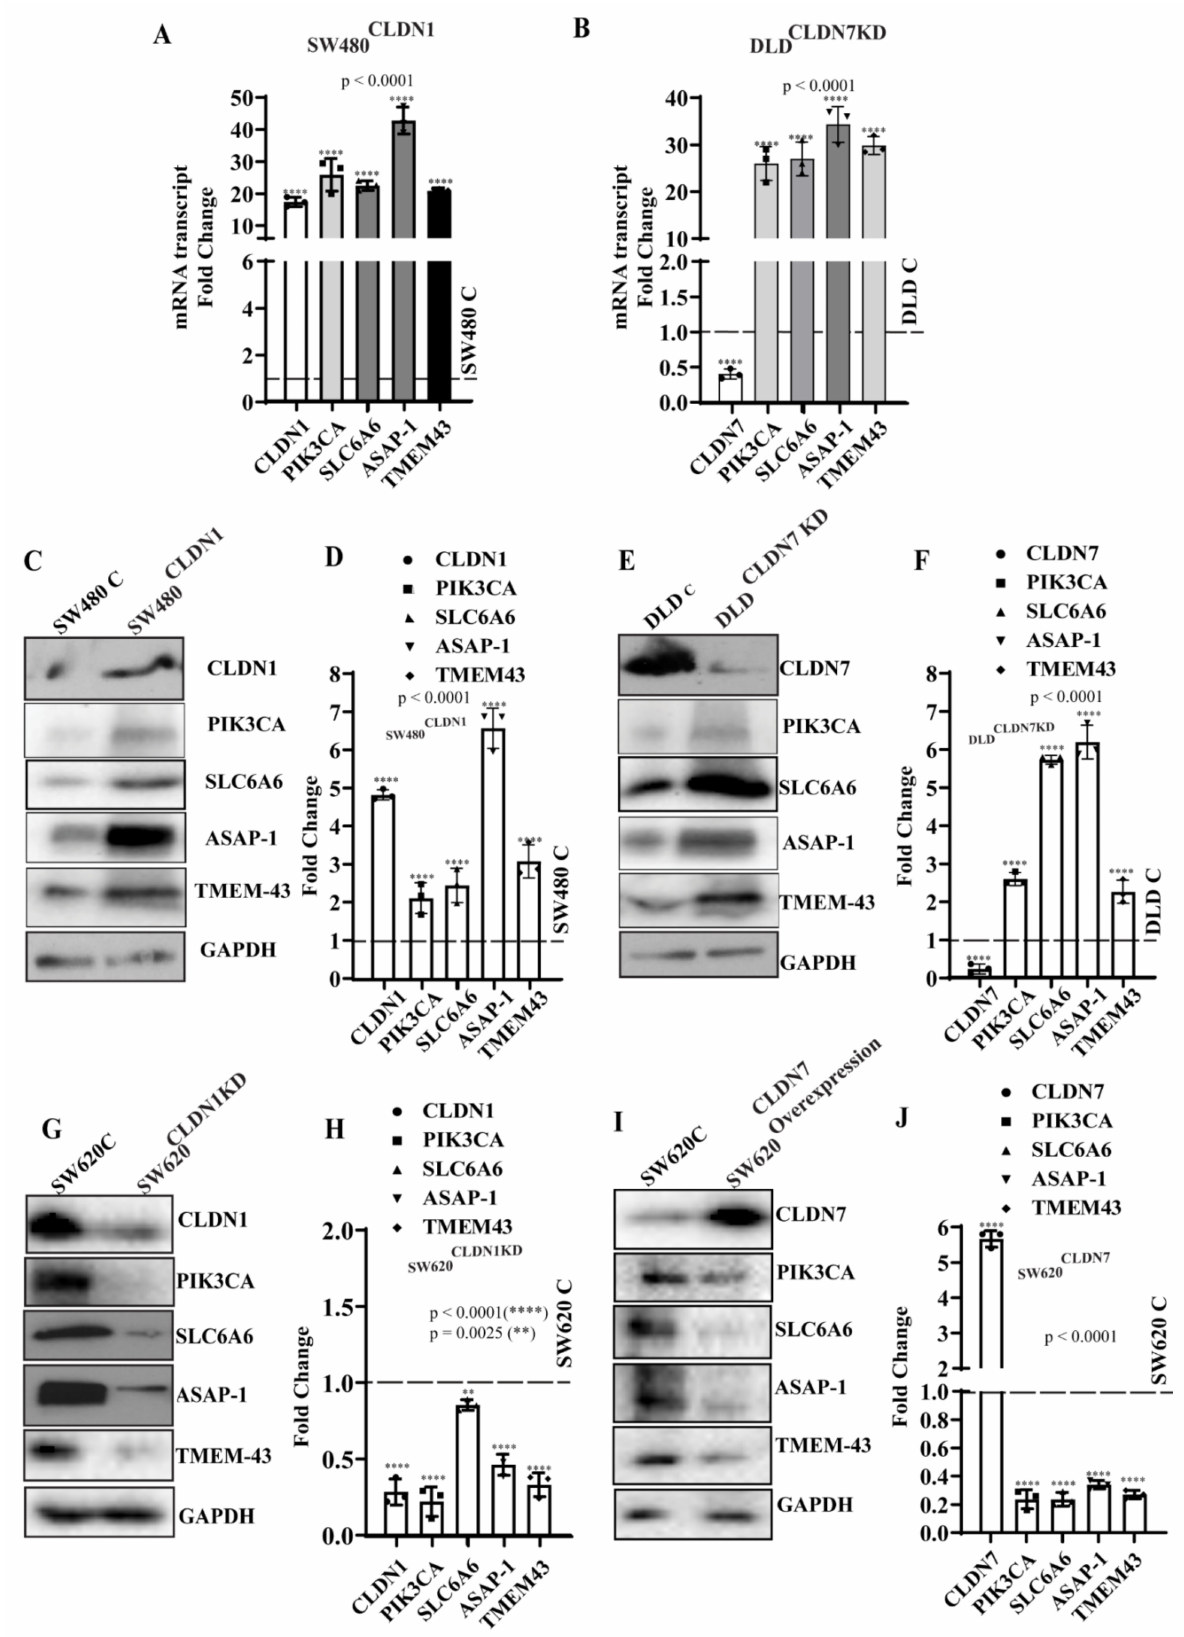
Figure 4. ( A , B ) qRT-PCR mRNA transcript analysis of CLDN1, CLDN7, PIK3CA, SLC6A6, ASAP-1, and TMEM-43 in SW480 Con , SW480 CLDN1 , DLD Con , and DLD CLDN7KD cells. Error bars represent the mean ± SD of three